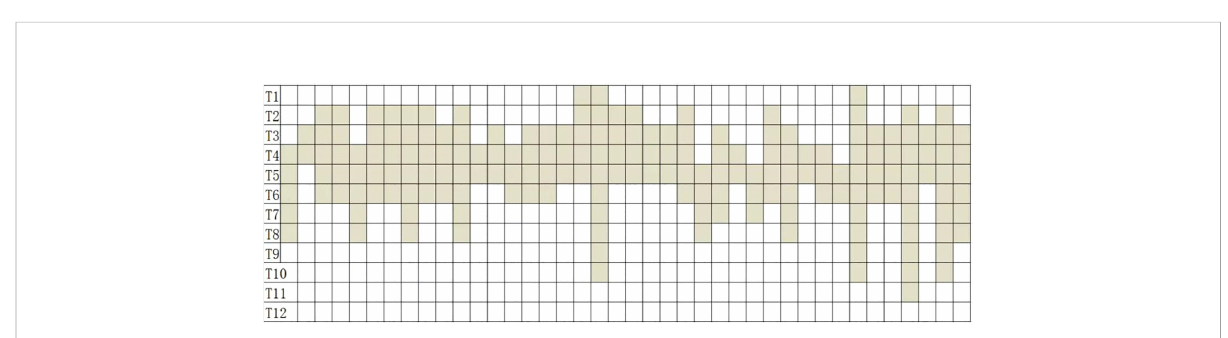
FIGURE 4 Skin hypoesthesia in 40 patients following ultrasound-guided TPVB.